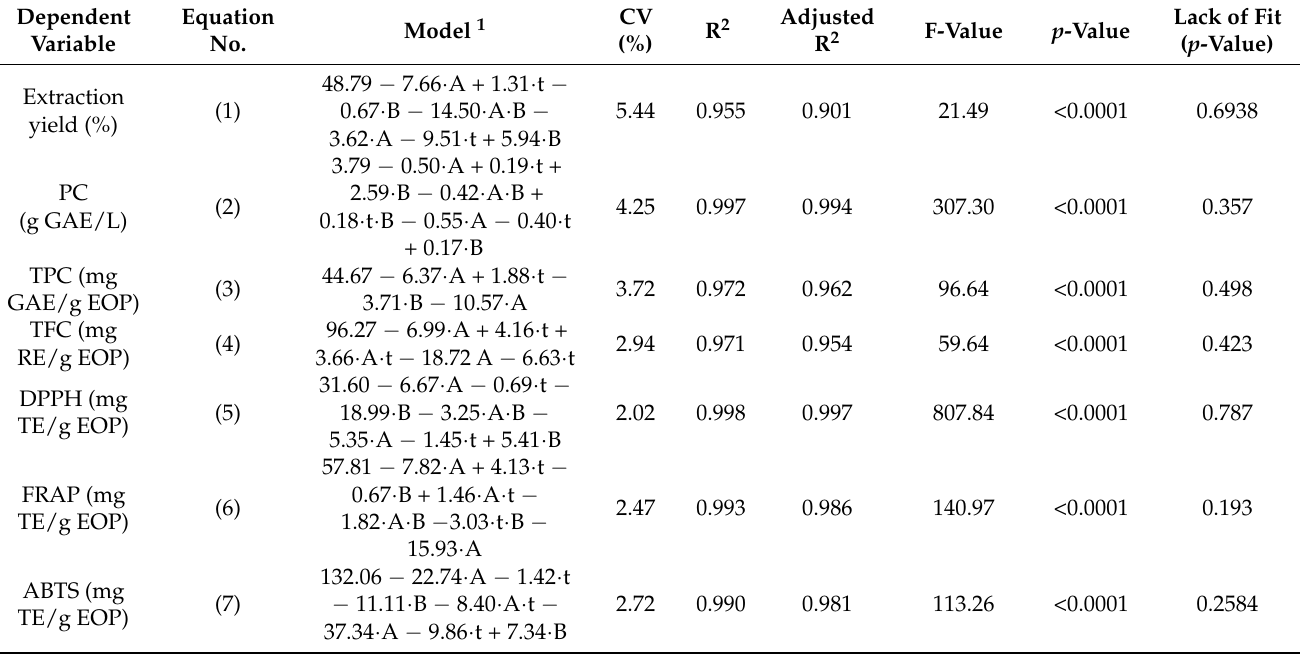
CV, coefficient of variation; FRAP, ferric-reducing power; GAE, gallic acid equivalents; PC, phenolic concentration; TE, Trolox equivalents; TFC, total flavonoid content; TPC, total phenolic content; RE, rutin equivalents. 1 Factors of the model: A, acetone concentration (%, v / v ); B, solid loading (%, w / v ); t, extraction time